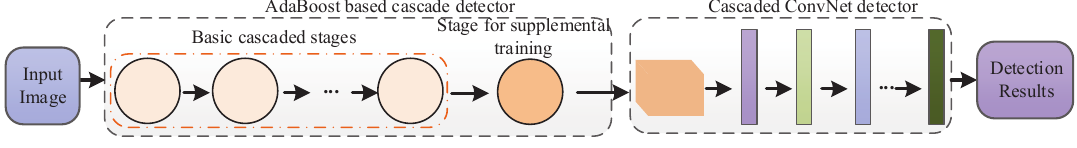
Figure 1. The structure of the proposed detection